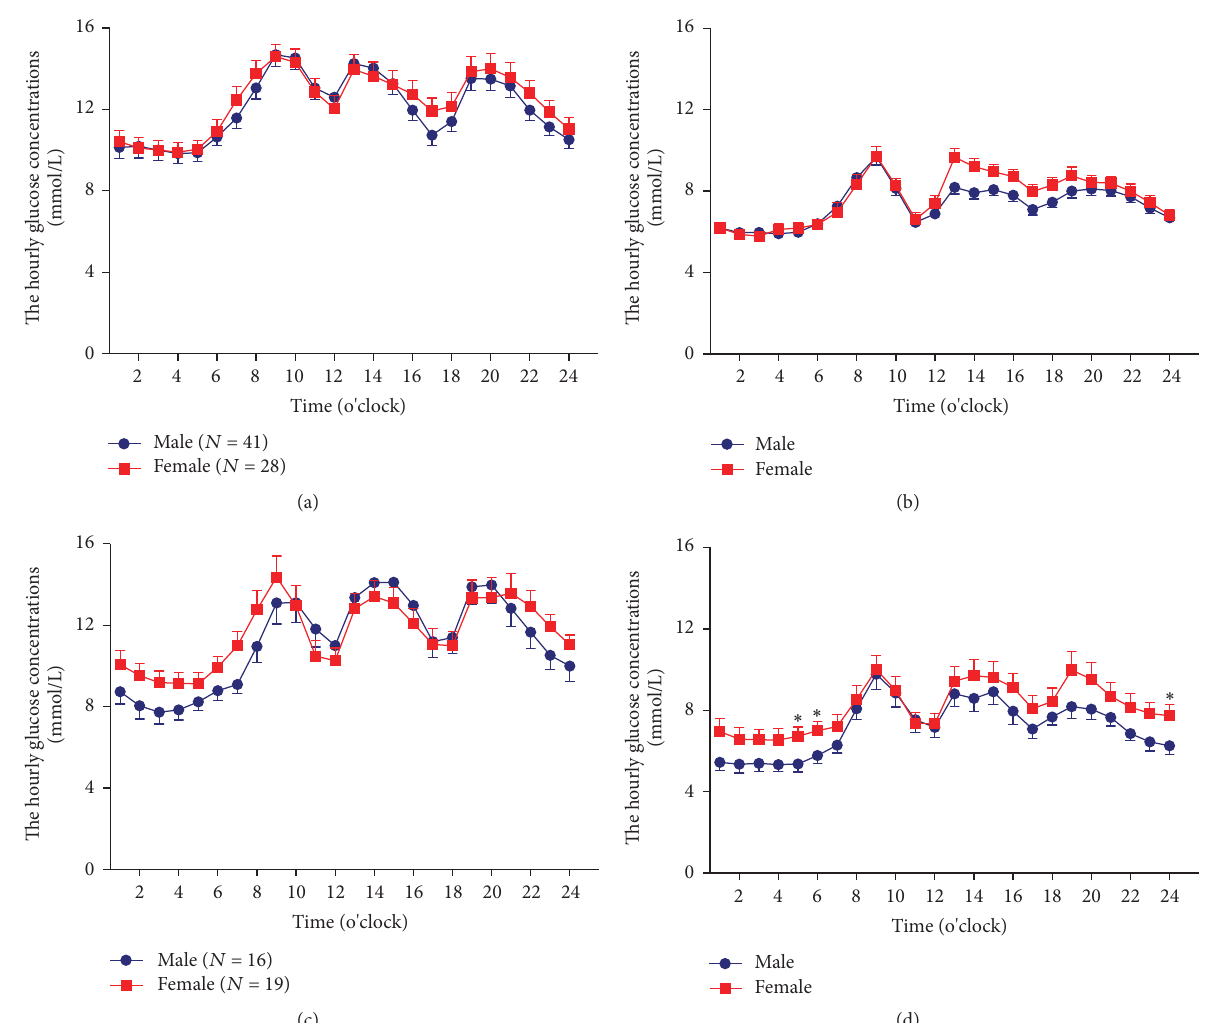
Figure 2: The hourly glucose concentrations calculated from CGM. The hourly glucose concentrations in young patients ( < 60 years) before (a) and after intensive insulin therapy treatment (b). The hourly glucose concentrations in older patients ( ≥ 60 years) before (c) and after intensive insulin therapy treatment (d). Data are presented as means ± SD. A two-way ANOVA was used in the comparison between groups, ∗ 𝑃 < 0.05